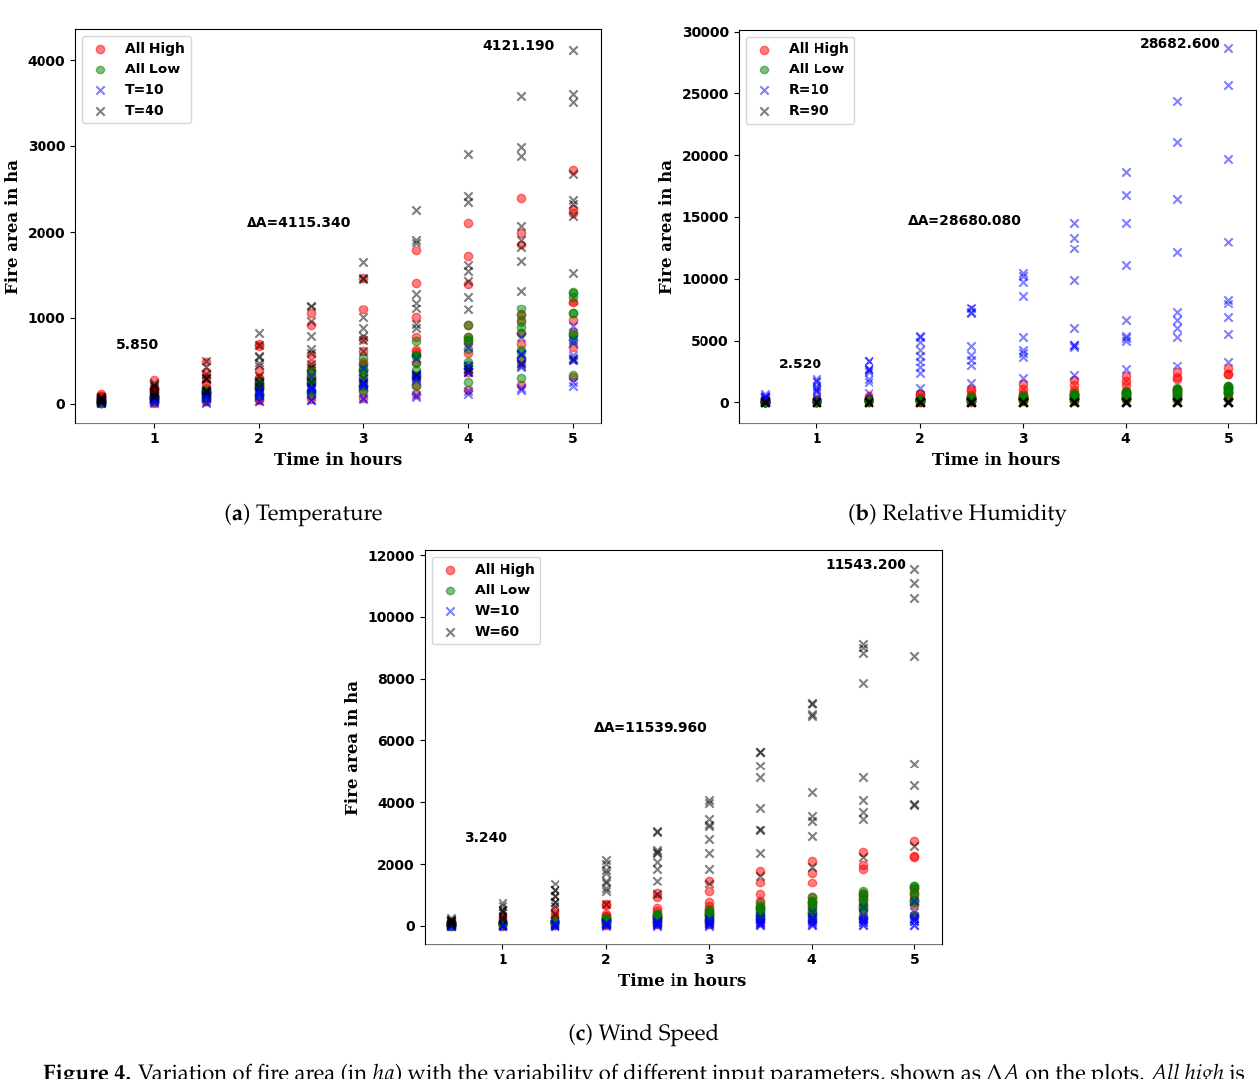
Figure 4. Variation of fire area (in ha ) with the variability of different input parameters, shown as ∆ A on the plots. All high is the plot for fire area obtained with maximum values of all parameters, while all low is with minimum values. The variation of fire area caused by relative humidity is the highest while that of the temperature is the